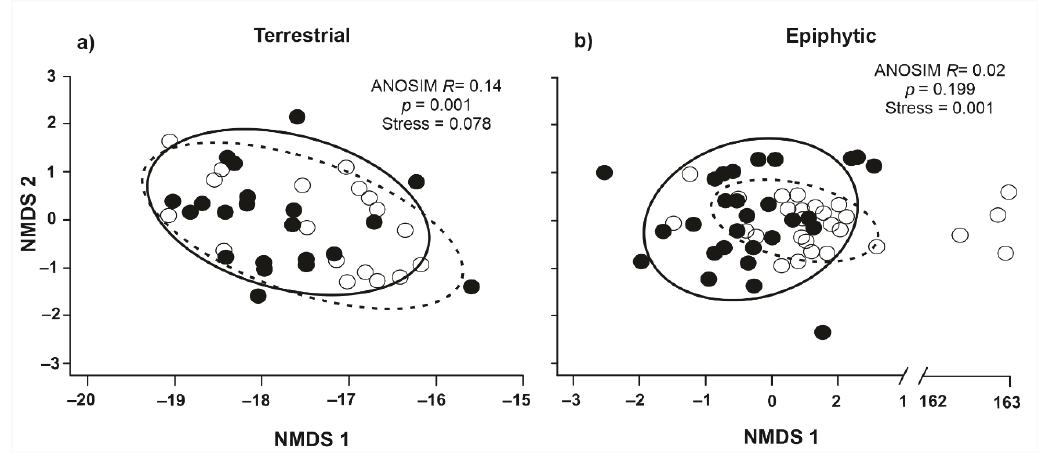
Figure 4. Non-metric multidimensional scaling (NMDS) of the terrestrial ( a ) and epiphytic ( b ) mosses in managed sites (hollow black circles and dotted ellipse) and conserved (solid black circles and continuous ellipse).